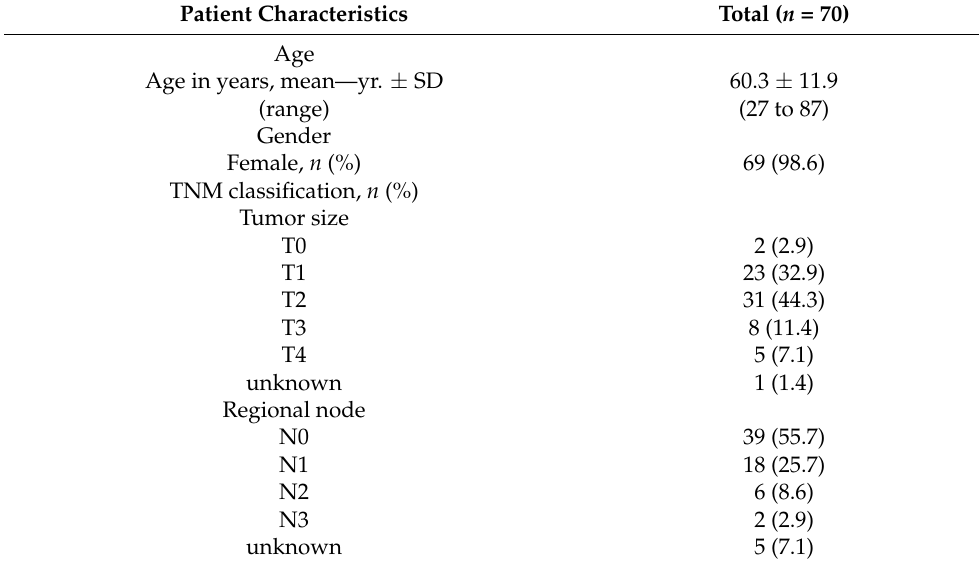
Table 1. Patient